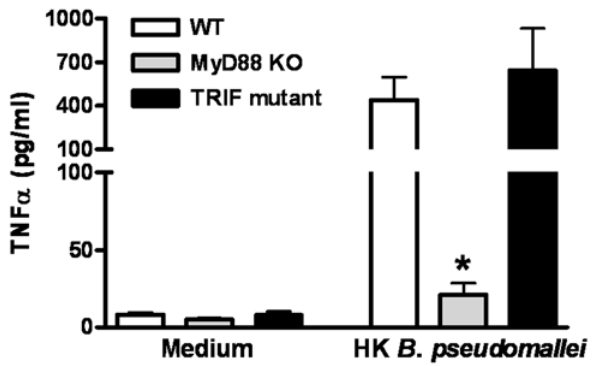
Figure 1. MyD88, but not TRIF, is required for cellular responsiveness to B.pseudomalleiinvitro . Whole blood of wild- type (WT; white bars), MyD88 knock-out (KO; grey bars) and TRIF mutant (black bars) mice were incubated with RPMI 1640 medium or heat-killed (HK) B. pseudomallei (5 6 10 7 CFU)/ml) for 16 hours before TNF a production was measured in the supernatant. Data are mean-